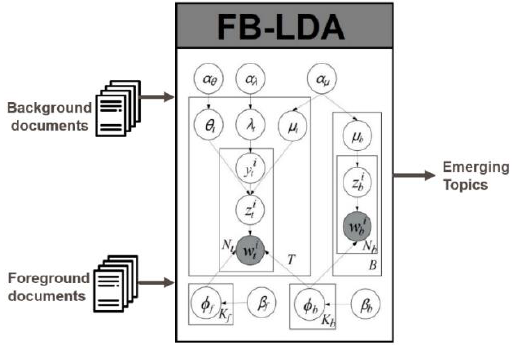
Figure 5. FB-LDA model.